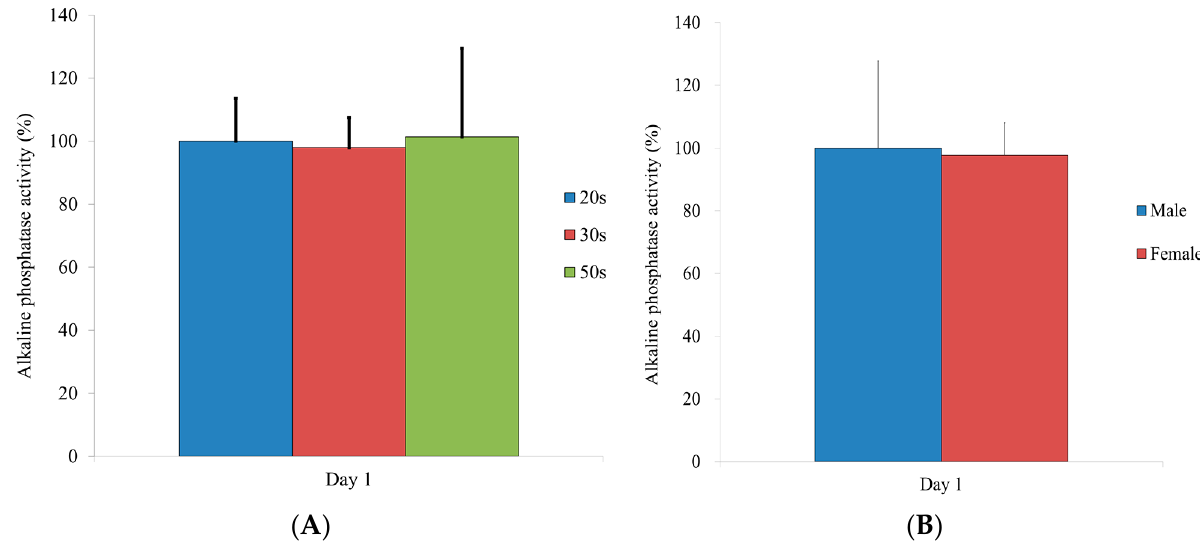
Figure 6. Alkaline phosphatase activity on Day 1. ( A ) Results from the different age groups. ( B ) Results on Day 1 by sex.